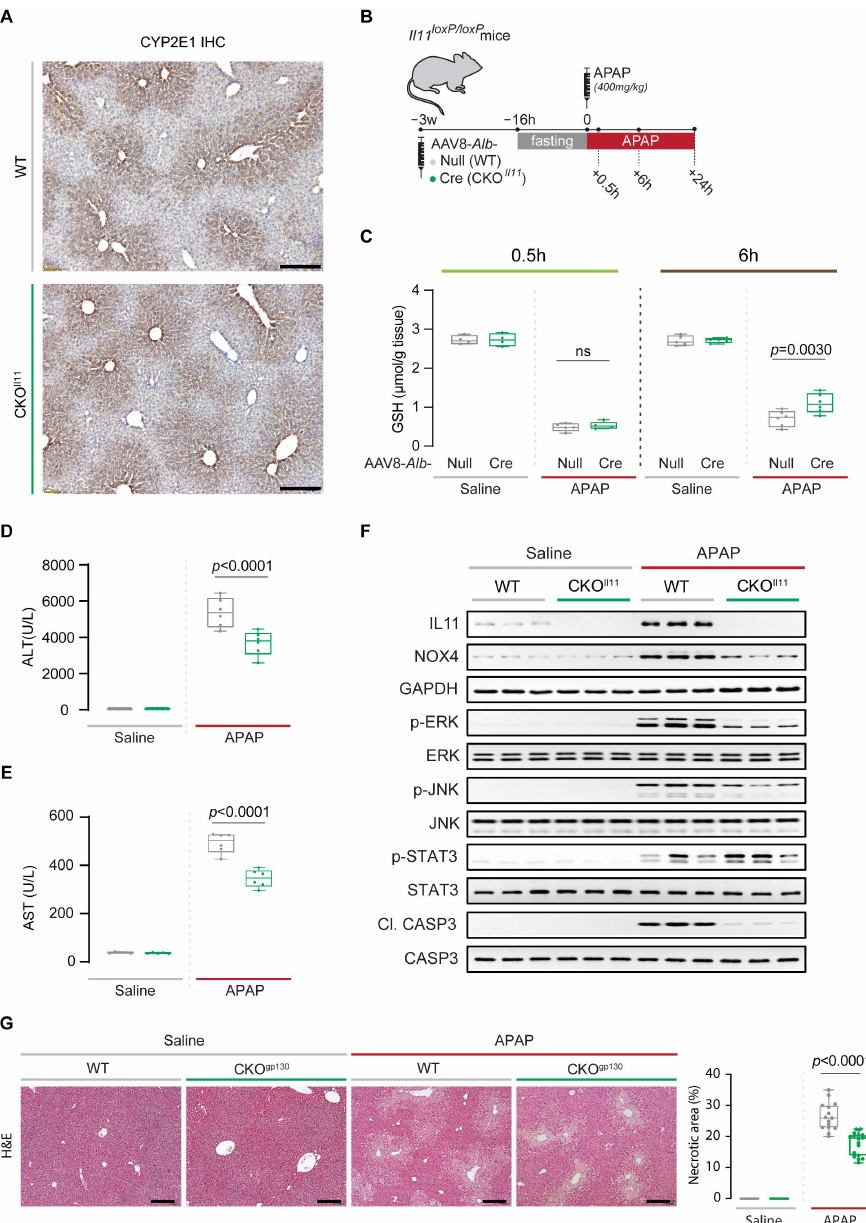
Figure 5. Hepatic CYP2E1 and glutathione levels and serum and molecular markers of liver injury in mice with hepatocyte-specific Il11 deletion and control mice. ( A ) Representative immunohisto- chemistry images (scale bars, 200 µ m; representative dataset from n = 3 mice/group). ( B ) Schematic of induction of APAP injury in wild-type (WT) and CKO Il11 mice: overnight-fasted mice were intraperitoneally injected with saline or APAP (400 mg kg − 1 ); livers and serum were collected either 0.5, 6, or 24 h following APAP administration for experiments shown in ( C – F ) and Figure 6. ( C ) Hepatic GSH concentrations at 0.5 and 6 h post-APAP. ( D ) ALT, ( E ) AST, and ( F ) Western blots of IL11, NOX4, GAPDH, p-ERK, ERK, p-JNK, JNK, Cl. CASP3, and CASP3 at 6 h post-APAP. ( G ) Representative H&E-stained liver images (scale bars, 200 µ m) at 6 h post-APAP dosing quan- tification of the liver necrotic area. ( C – E , G ) Data are shown in a box-and-whisker plot with median (middle line), 25th–75th percentiles (box), and min-max values (whiskers), with a 2-way ANOVA with Sidak’s correction; 0.5 h time point: saline ( n = 4 mice/genotype), APAP ( n = 4 mice/genotype), 6 h time point: saline ( n = 5 mice/genotype), APAP ( n = 6